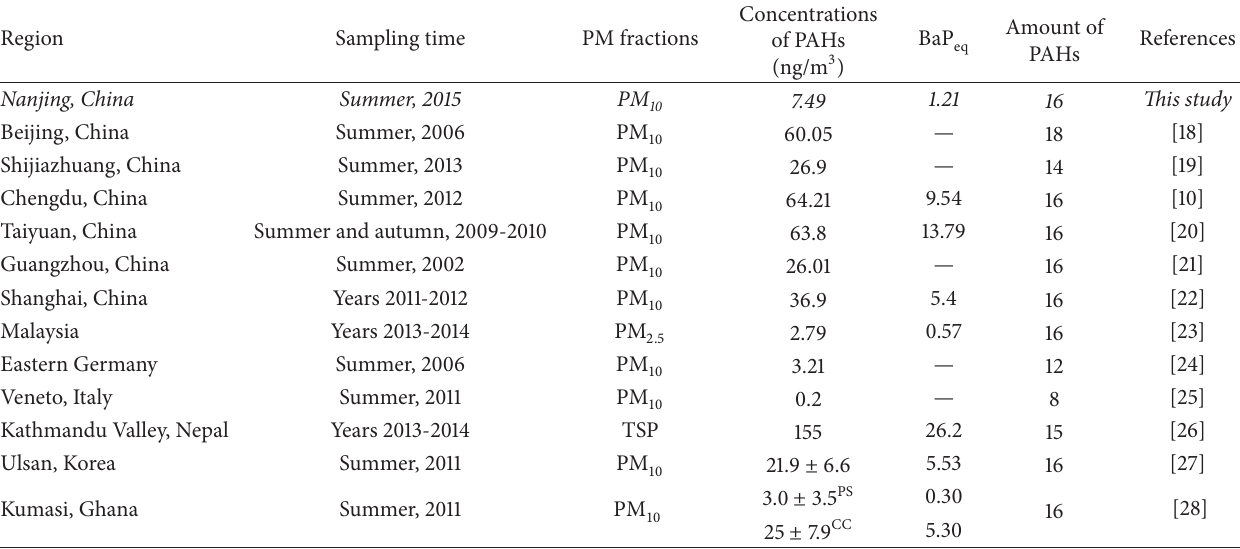
Table 2: Comparisons of PAHs concentrations (ng/m 3 ) in PM 10 among Nanjing and other regions.